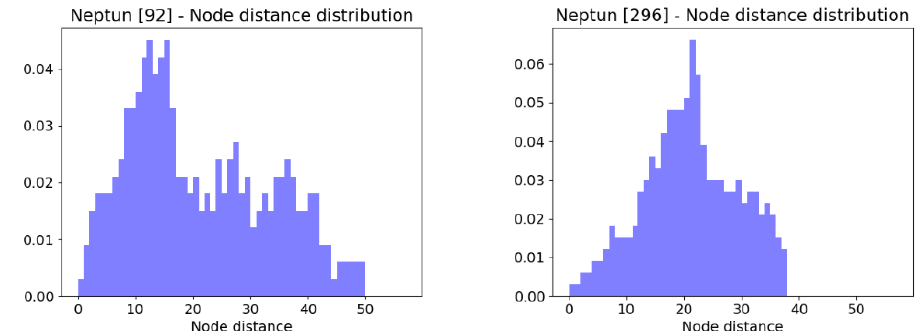
Figure 6. The node-to-node distance distribution of node 92 ( left ) (mean = 20.74, std = 12.18) and node 296 ( right ) (mean = 20.72, std = 8.19).